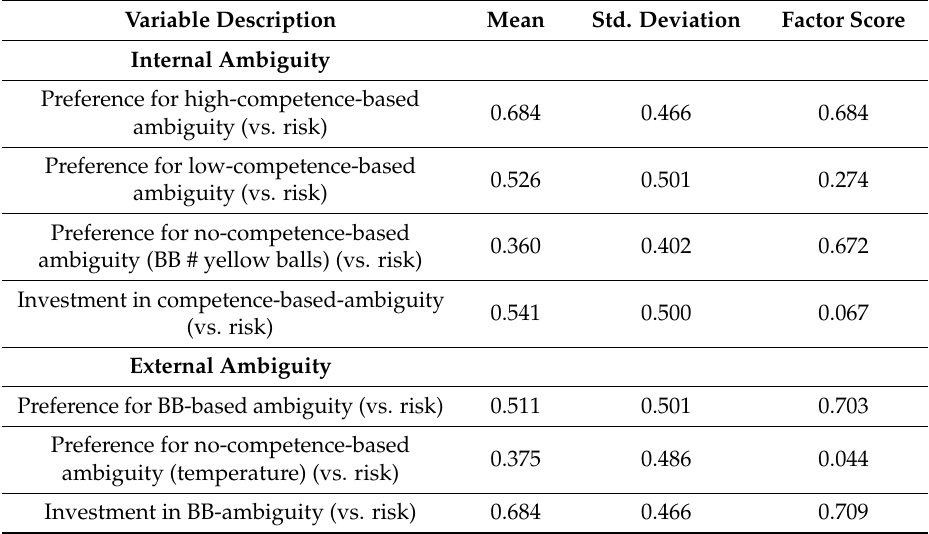
Table 7. The Principal Component